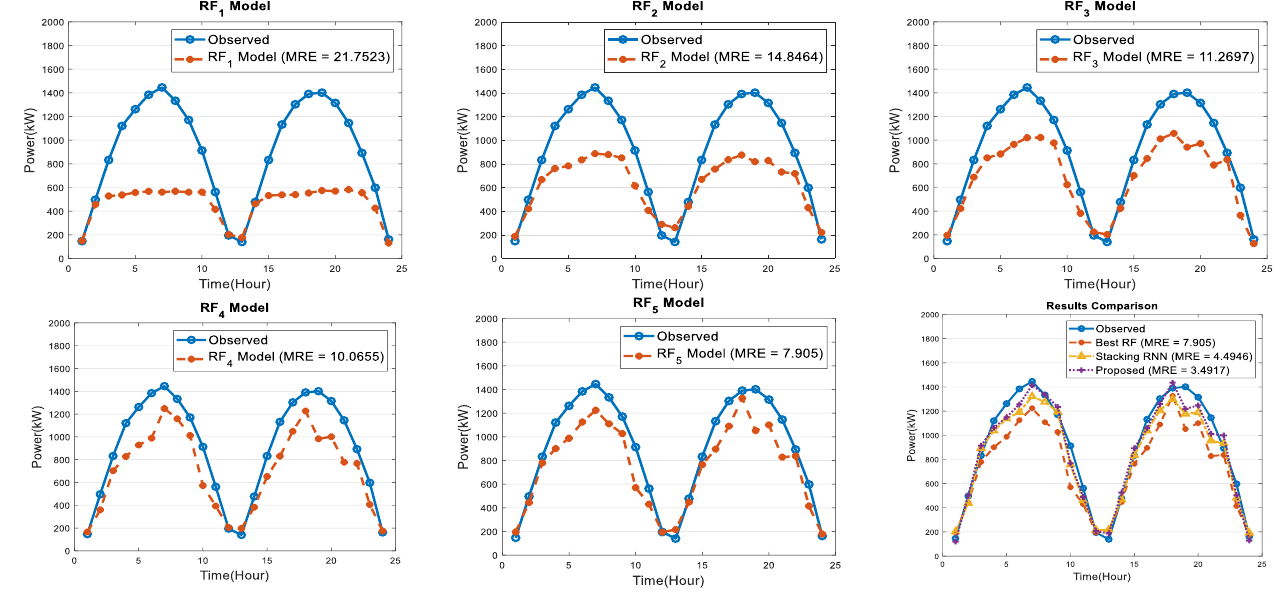
Figure 9. Results for one-day-ahead PV power forecasting for sunny weather conditions.